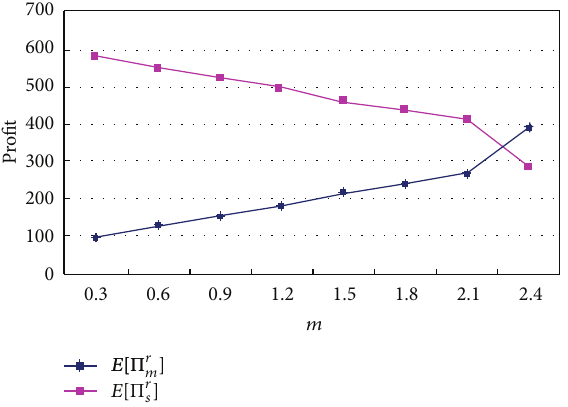
Figure 3: The relation between 𝑚 , 𝐸[Π 𝑟 𝑠 ] , and 𝐸[Π 𝑟 𝑚 ]